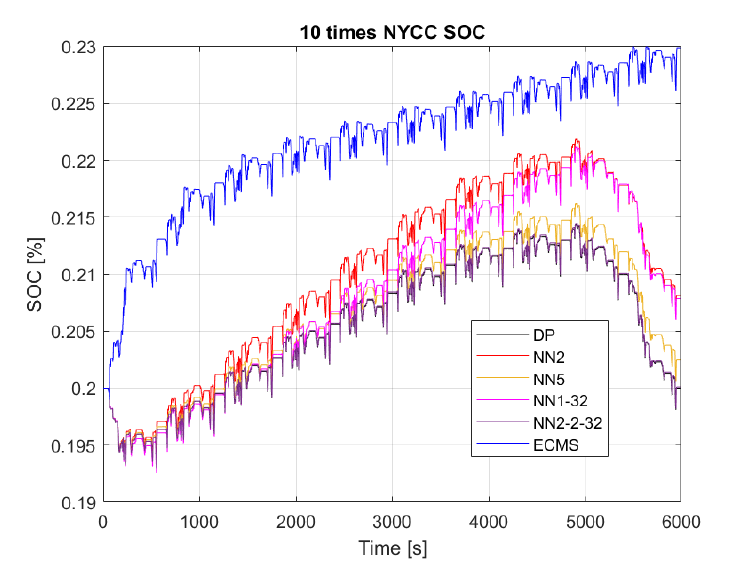
Figure 11. SOC results for UDDS repeated 10 times.